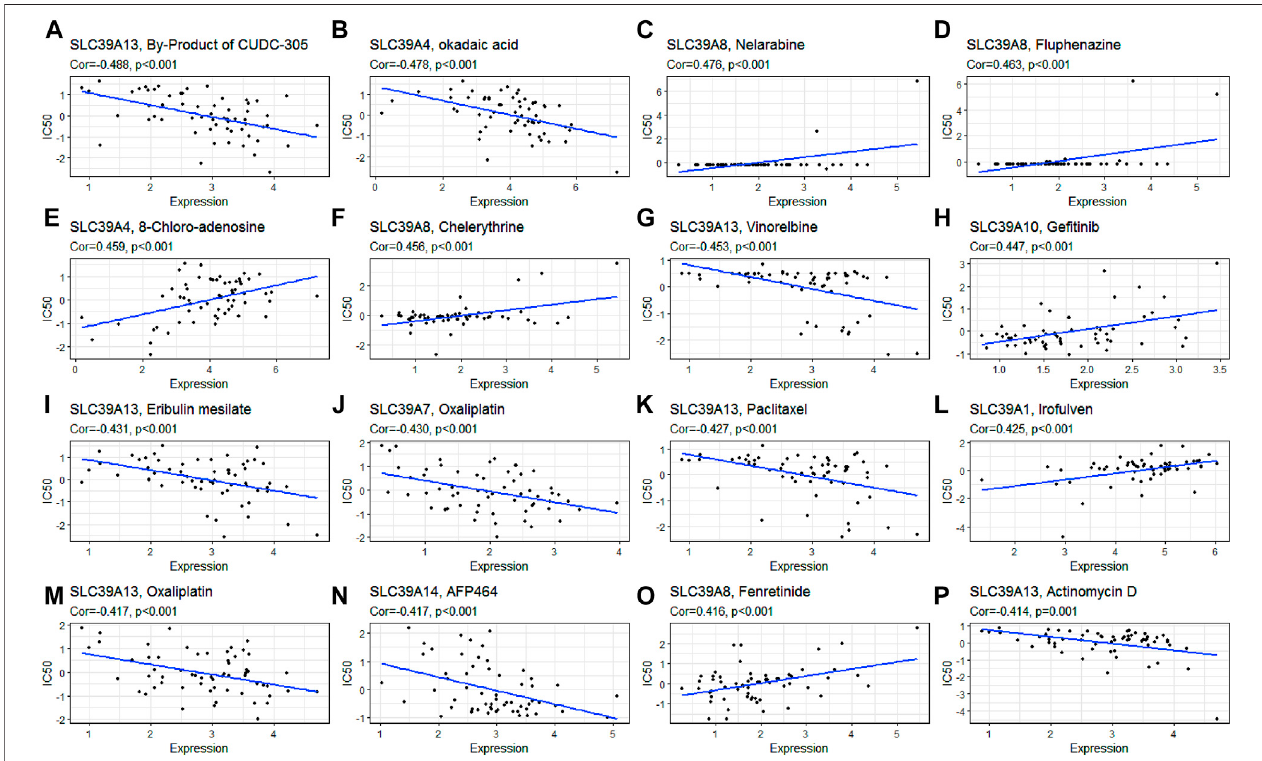
FIGURE8| Associationofthe SLC39A familygeneexpressionwiththedrugsensitivityderivedfromtheNCI-60celllinedata. (A) Scatterplotofnegativecorrelation between SLC39A13 expression and the sensitivity of the by-product of CUDC-305. (B) Scatter plot of negative correlation between SLC39A4 expression and the sensitivity of okadaic acid. (C) Scatter plot of positive correlation between SLC39A8 expression and the sensitivity of nelarabine. (D) Scatter plot of positive correlation between SLC39A8 expression and the sensitivity of fl uphenazine. (E) Scatter plot of positive correlation between SLC39A4 expression and the sensitivity of 8- chloro-adenosine. (F) Scatter plot of negative correlation between SLC39A13 expression and the sensitivity of chelerythrine. (G) Scatter plot of positive correlation between SLC39A4 expression and the sensitivity of vinorelbine. (H) Scatter plot of positive correlation between SLC39A10 expression and the sensitivity of ge fi tinib. (I) Scatter plot of negative correlation between SLC39A13 expression and the sensitivity of eribulin mesilate. (J) Scatter plot of negative correlation between SLC39A7 expression and the sensitivity of oxaliplatin. (K) Scatter plot of negative correlation between SLC39A13 expression and the sensitivity of paclitaxel. (L) Scatter plot of positive correlation between SLC39A1 expression and the sensitivity of Irofulven. (M) Scatter plot of negative correlation between SLC39A13 expression and the sensitivity of oxaliplatin. (N) Scatter plot of negative correlation between SLC39A14 expression and the sensitivity of AFP464. (O) Scatter plot of positive correlation between SLC39A8 expressionand thesensitivity offenretinide. (P) Scatterplotofnegativecorrelationbetween SLC39A13 expressionand thesensitivity ofactinomycin D. Z-score from test by Pearson ’ s correlation using NCI-60 cell line data.